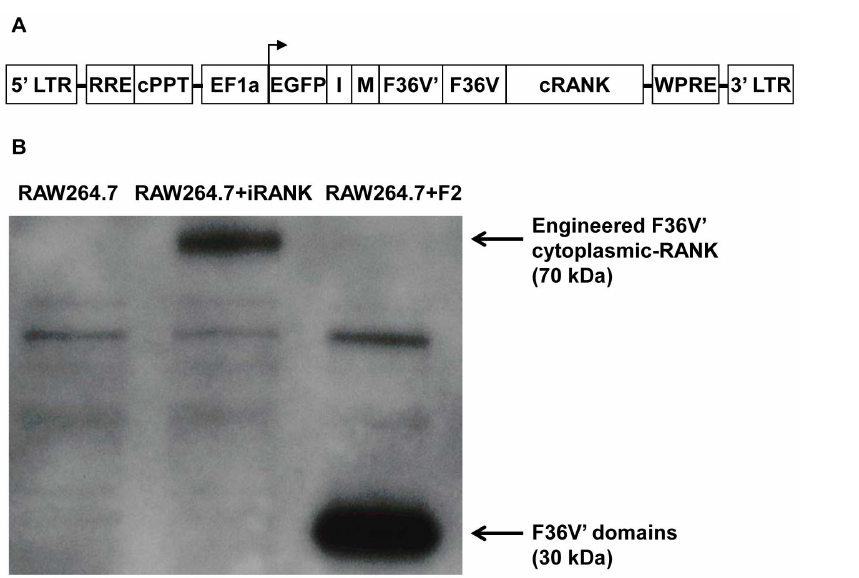
Figure 1. Schematic representation of CID-inducible cytoplasmic RANK (iRANK) lentiviral construct and Western blot detecting construct. A) LTR=long terminal repeat; RRE=rev response element; cPPT=central polypurine tract; EF1a=elongation factor 1-Alpha; EGFP=green fluorescent protein; I=IRES; M=myristoylation; F36V=FKBP12; F36V’=modified FKBP12; cRANK=cytoplasmic domain of RANK; WPRE=WHP posttranscriptional regulatory element. B) Western blot probed with an antibody for FKBP12 showing overexpression of the iRANK construct in RAW264.7 + iRANK cells migrating around 70 kDa. Cells transduced just with the F36V’ domains (RAW264.7 + F2) show a band around 30 kDa. No bands appear in the untransduced RAW264.7 cells.